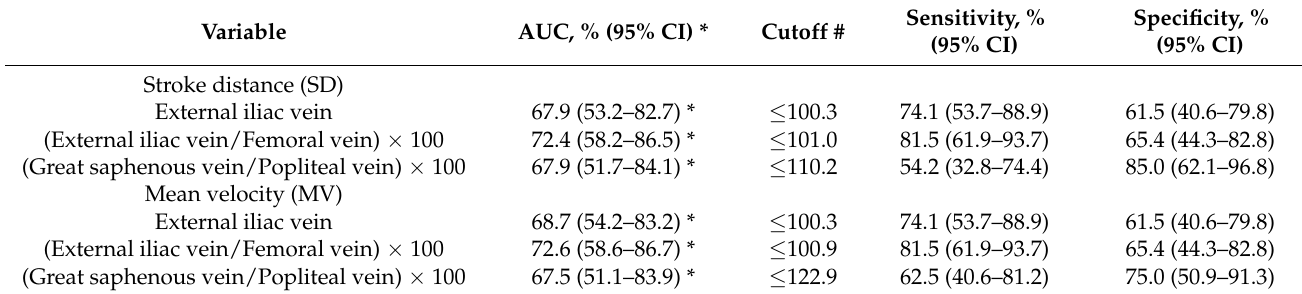
Table 3. The area under curve (AUC) was analyzed to define an optimal cutoff value if the t -test results reached a p -value <